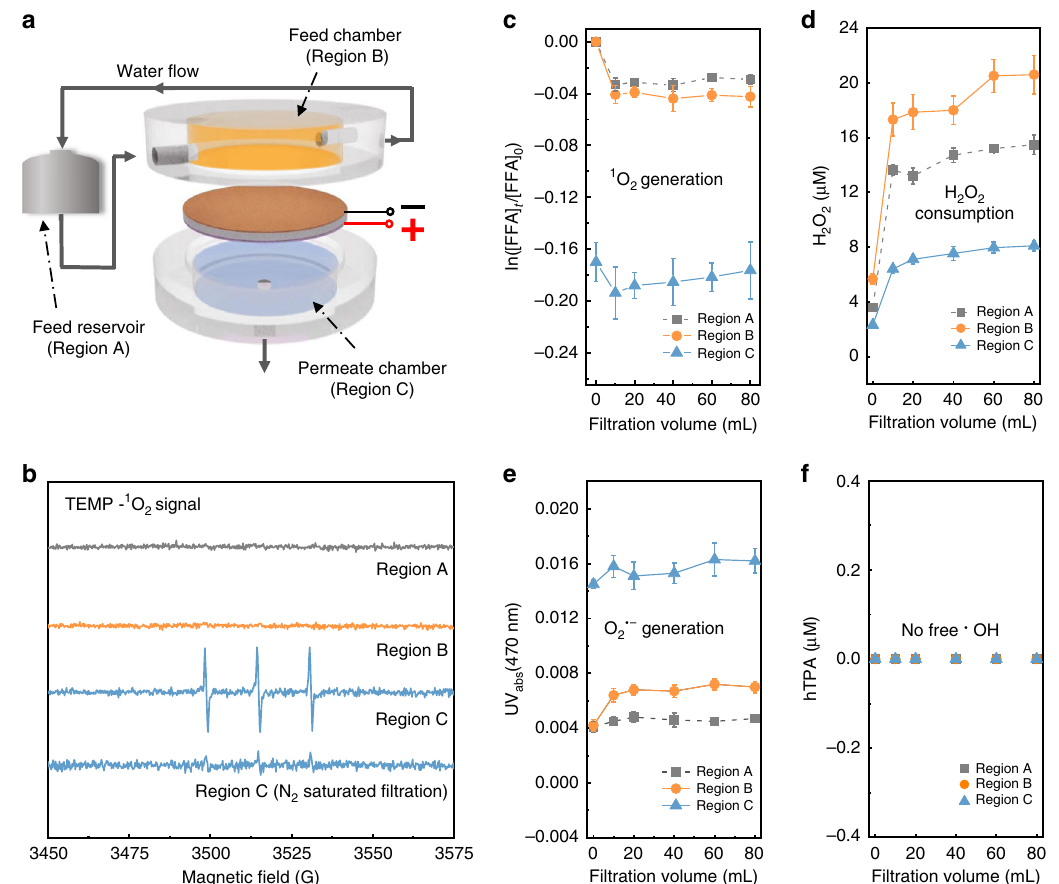
Fig. 2 Spatiotemporal distribution of reactive oxygen species (ROS) generated in the Pd – Pt – CM. a Schematic illustrating the cross- fl ow fi ltration system containing a feed reservoir (Region A, gray) and an electro fi ltration module with a 12 mL feed chamber (Region B, orange), a 12 mL permeate chamber (Region C, blue), and the Pd – Pt – CM. b EPR analysis for 1 O 2 in different regions of the fi ltration system using 2,2,6,6-tetramethylpiperidine (TEMP, 25 mM) as the trapping agent. EPR measurement of the TEMP- 1 O 2 adduct in the permeate (Region C) of the fi ltration system using an N 2 -saturated feed solution is conducted for comparison. c 1 O 2 generation indicated by the degradation of furfuryl alcohol (FFA, 50 μ M). d H 2 O 2 detection measured by Amplex Red color reaction. e Detection of O 2 (cid:129) − by using 2,3-Bis-(2-methoxy-4-nitro-5-sulfophenyl)-2H-tetrazolium-5-carboxanilide (XTT, 100 μ M) as the probe. f (cid:129) OH measurement by applying terephthalate (TPA, 1 mM) which reacts with (cid:129) OH to form hydroxyterephthalate (hTPA). Error bars represent standard deviations from triplicate